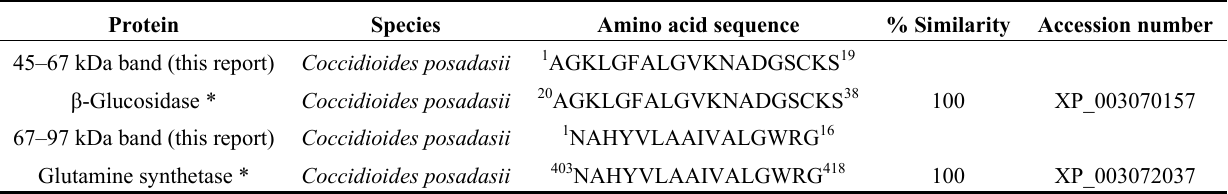
Table 1. Comparison of N-terminal sequences of 45–67 kDa and 67–97 kDa bands of in house antigen with similar protein